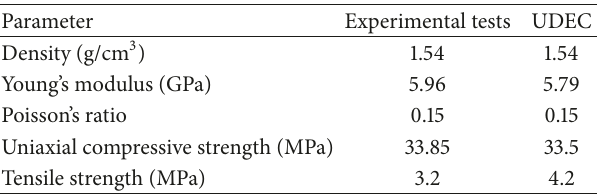
Table 1: The parameters of gypsum in experimental tests [1] and numerical simulations.